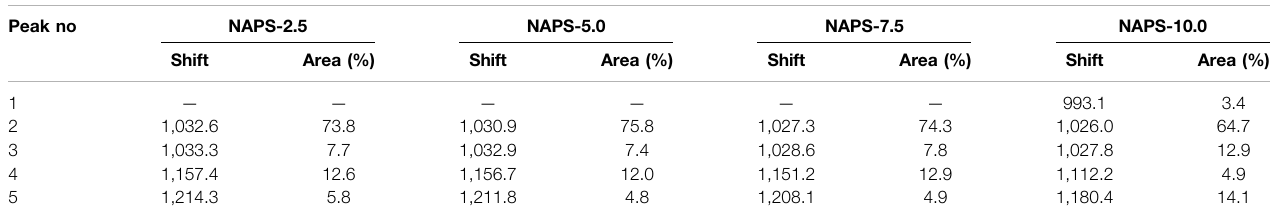
TABLE 2 | Raman spectra deconvolution